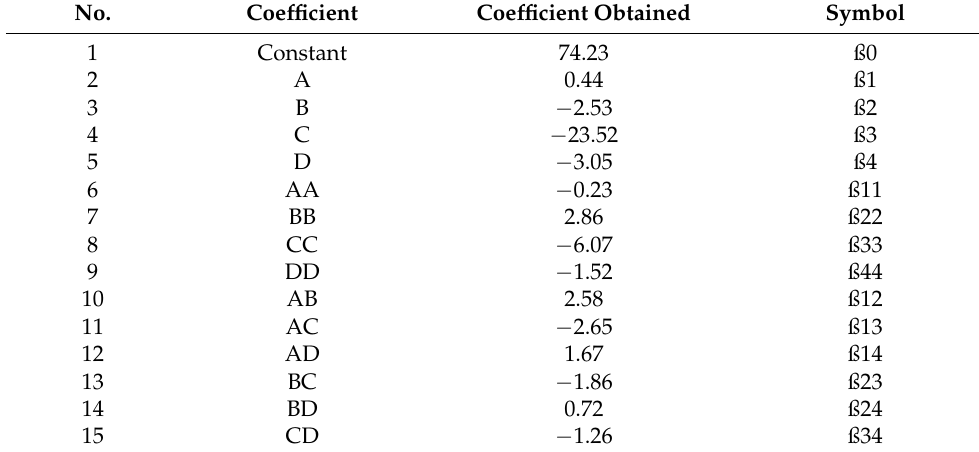
Table 5. Obtained regression coefficients of the optimization model according to Equation (4). No. Coefficient Coefficient Obtained